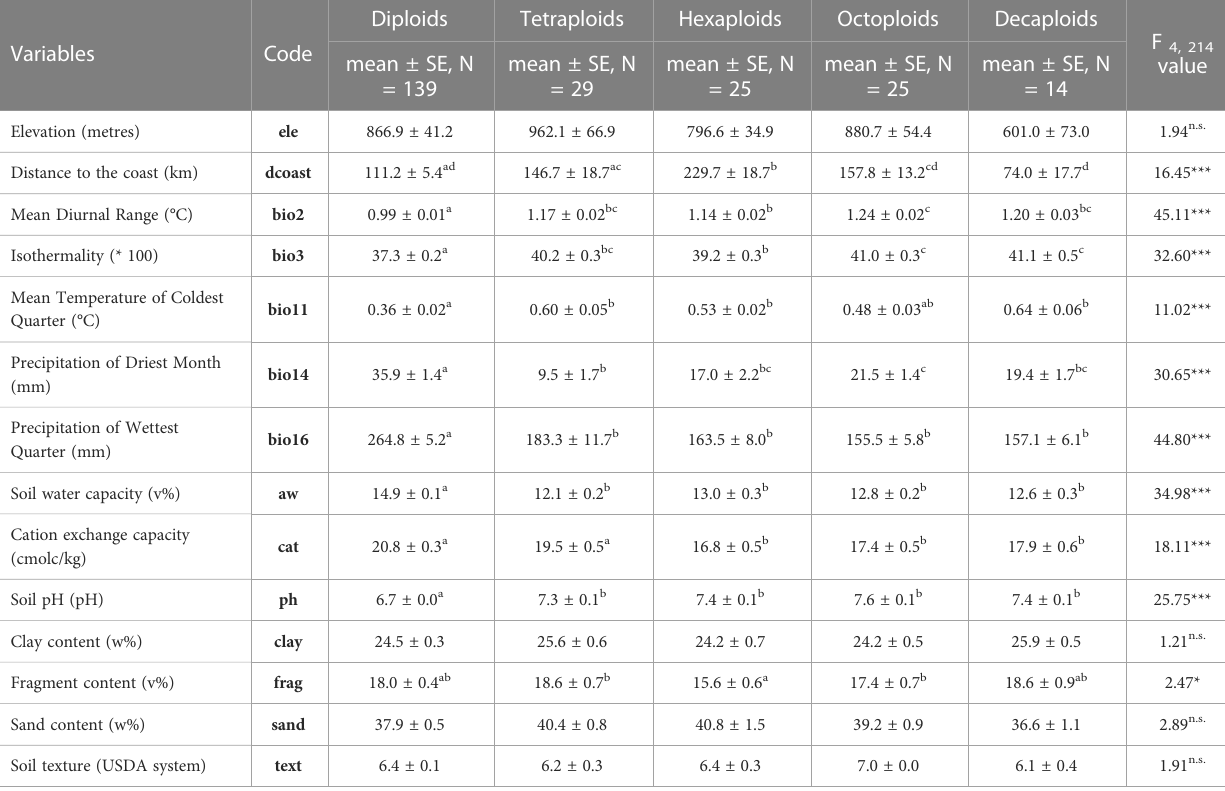
TABLE 2 Mean and standard error of the mean (SE) of selected variables used to characterise the niche of Linum suffruticosum s.l. cytotypes.